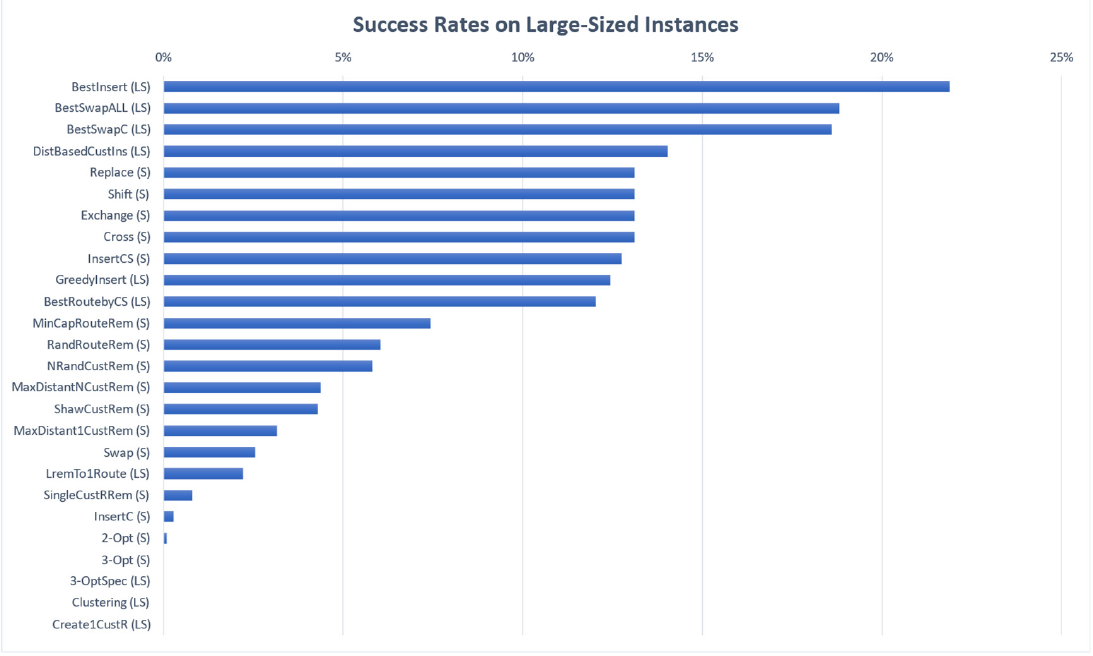
Figure 3. Most-successful operators in shaking and local search steps in large-sized instances .